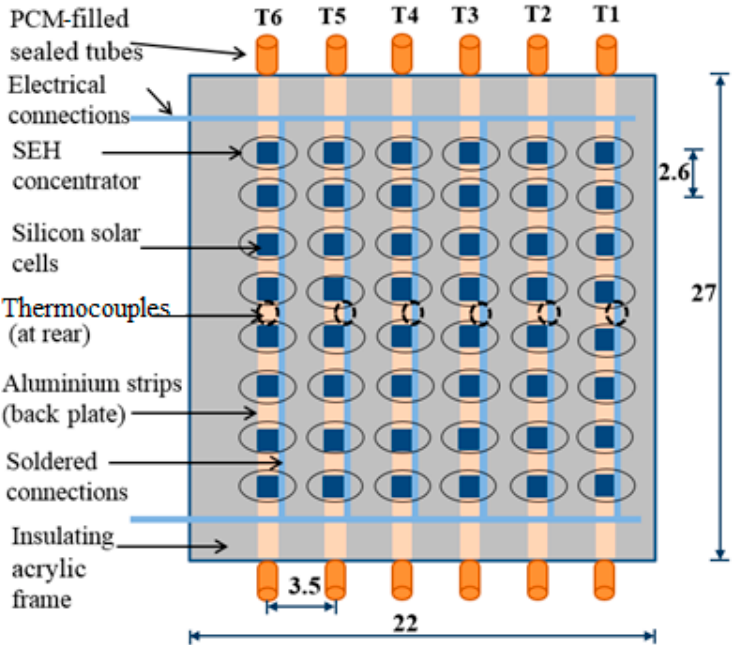
Figure 1. Schematic of the WICPV system with PCM-filled copper tubes (all dimensions in mm); adapted from [26].